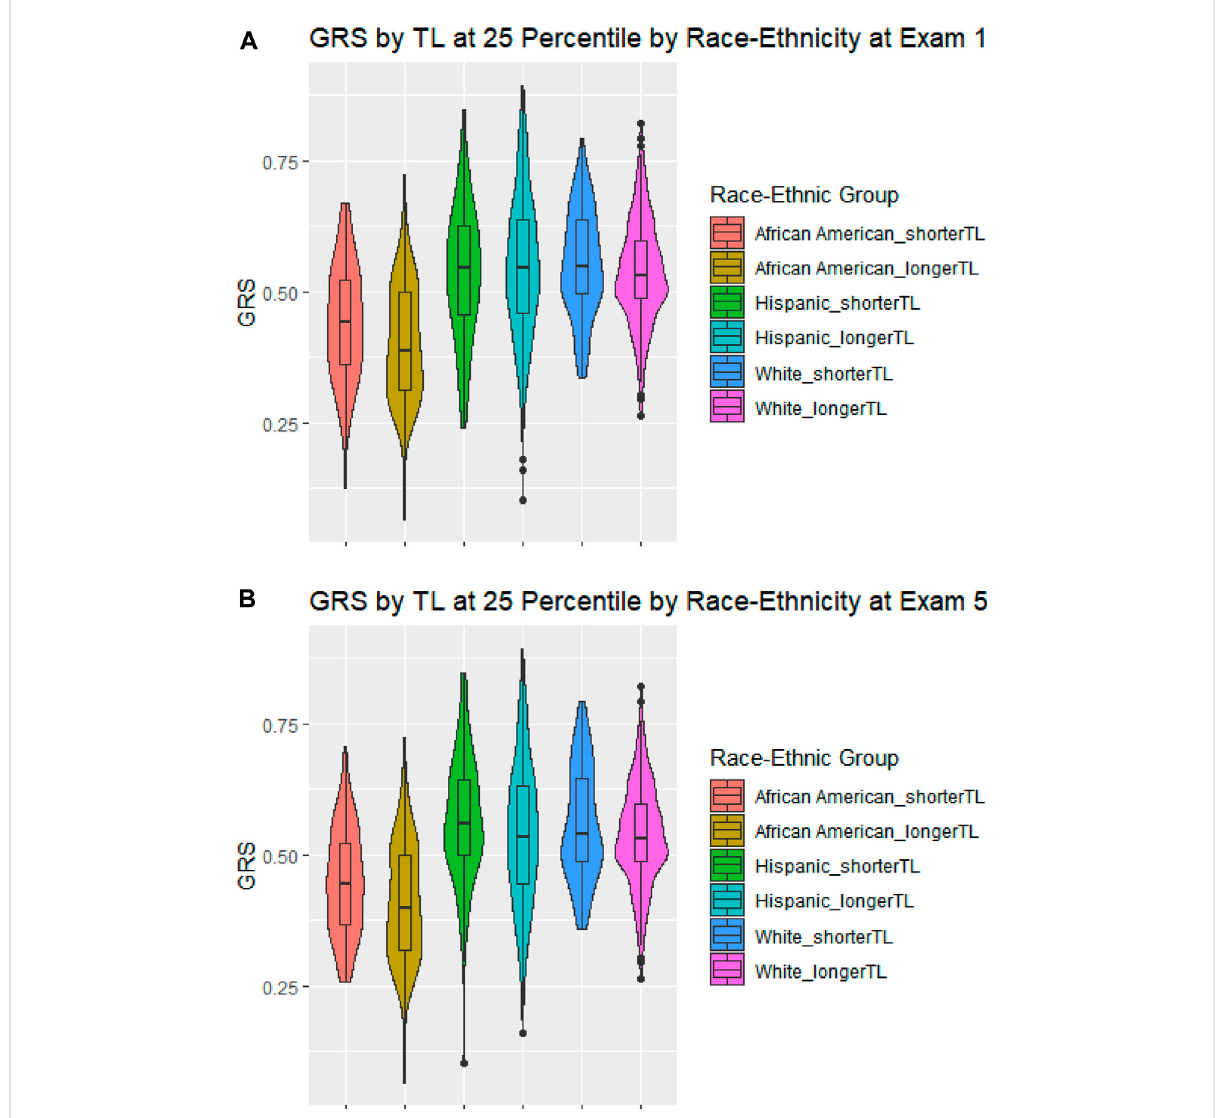
FIGURE 2 ViolinPlotsoftheGRS-TLdistributionsstrati fi edbyrace/ethnicity.ViolinPlotsoftheGRS-TLdistributionsincludingaboxplotwithmedian,and quartiles strati fi ed by race/ethnicity for those at or below the 25th percentile of TL (shorter TL) and those above the25th percentile of TL (longer TL). Panel (A) GRS by TL at 25 Percentile by Race-Ethnicity at Exam 1; Panel (B) GRS by TL at 25 Percentile by Race-Ethnicity at Exam